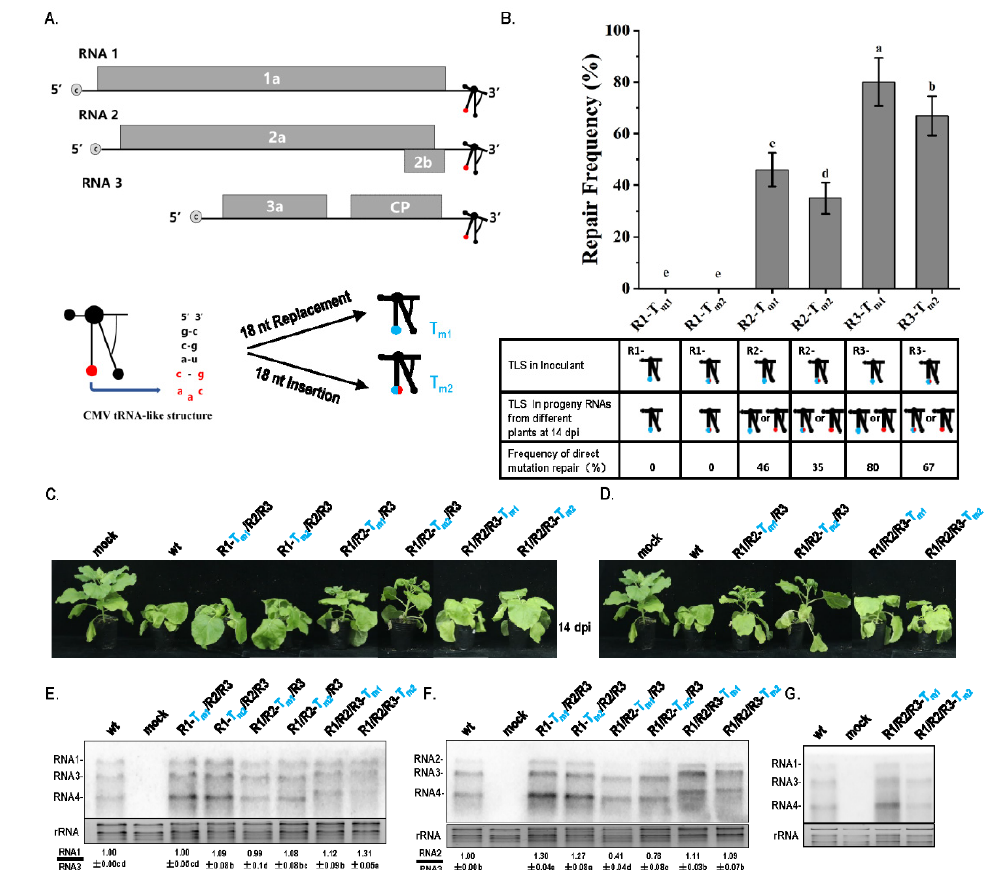
Figure 1. The repair frequency and pathogenicity of TLS mutation in different CMV RNAs. ( A ) Schematic representation of CMV and mutation on TLS. TLS is indicated by special branch structure, and essential caacg loop is indicated by solid red circle. Mutation of 18 nt replacement on caacg (T m1 ) or 18 nt insertion before caacg (T m2 ) is indicated by solid blue circle. ( B ) Frequency of repair of TLS mutation in RNAs of CMV Fny . R1—RNA1 of CMV Fny ; R2—RNA2 of CMV Fny ; R3—RNA3 of CMV Fny . ( C ) Pathogenicity of different TLS mutants without mutation repair: wt—RNA1/RNA2/RNA3 of wild-type CMV Fny . ( D ) Pathogenicity of different TLS mutants with mutation repair. ( E ) Northern blot for RNA samples without direct repair of TLS mutation, using probes against RNA1, RNA3, and RNA4. ( F ) Northern blot for RNA samples without direct repair of TLS mutation, using probes against RNA2, RNA3, and RNA4. The blot signals were analyzed with Quantity One software. ( G ) Northern blot for RNA samples with TLS mutation repair, using probes against RNA1, RNA3, and RNA4. The data were analyzed with independent sample LSD tests using DPS software, different letters indicate that values of the two treatments were significantly different at p < 0.05. 3.2. Quality or Quantity Defects of Genomic RNAs via TLS Mutation in RNA2 or RNA3 of CMV, Triggering the Repair Mechanism To further identify the factors of mutation repair, the effect of different TLS mutations on CMV pathogenicity and RNA accumulation was analyzed. Mutants R1-T m1 and R1-T m2 had similar pathogenicity to wt and caused severe stunting (Figure 1C). Mutants R2-T m1 and R2-T m2 had weak pathogenicity, causing a little stunting (Figure 1C). Mutants R3-T m1 and R3-T m2 had a weaker pathogenicity and stunting effect than that of wt (Figure 1C). Therefore, identical TLS mutations in RNA1, RNA2, and RNA3 had different effects on CMV pathogenicity. When the TLS mutation in RNA2 or RNA3 was repaired, symptoms of the mutant precursor were still noticed (Figure 1D), which implies that mutation repair requires a process, not a sudden action. To identify why TLS mutations in RNA1, RNA2, and RNA3 had different effects on CMV pathogenicity, the characteristics of CMV RNAs in samples without direct TLS mutation repair were analyzed by Northern blot (Figure 1E,F).